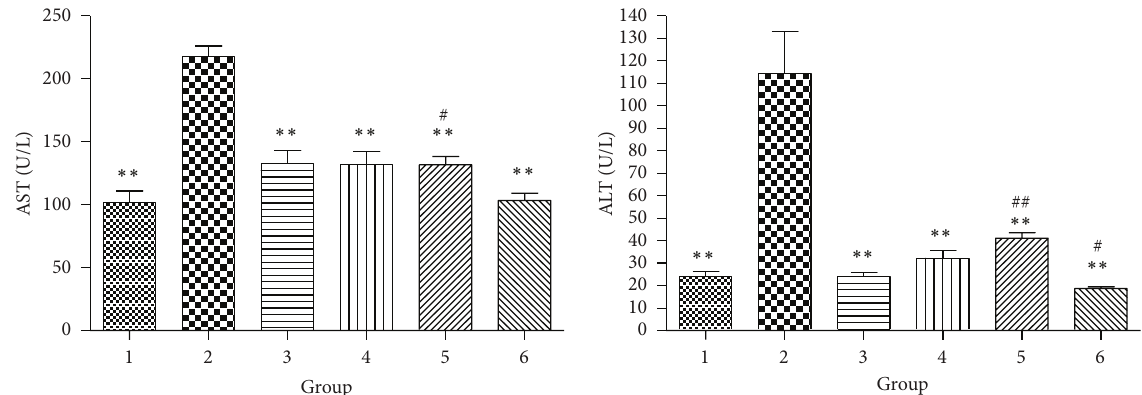
Figure 5: Levels of AST and ALT in serum ( ∗ 𝑃 < 0.05 compared with Group 2. ∗∗ 𝑃 < 0.01 compared with Group 2; # 𝑃 < 0.05 compared with Group 1. ## 𝑃 < 0.01 compared with Group 1).